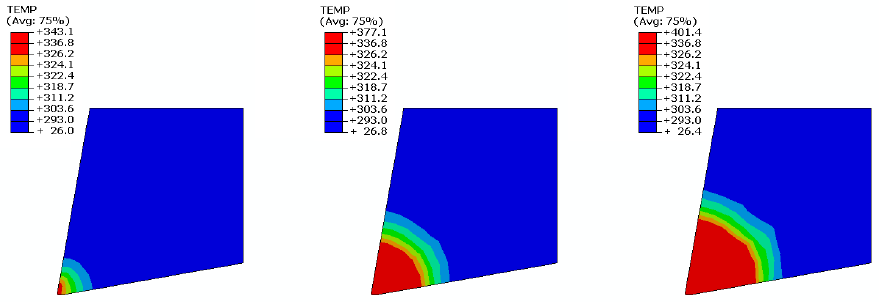
Figure 4. Temperature T [K] distribution on the tool’s tip for constant cutting speed 500 mm/s during machining materials with different densities: 10 PCF ( left ), 25 PCF ( middle ), and 40 PCF ( right ).